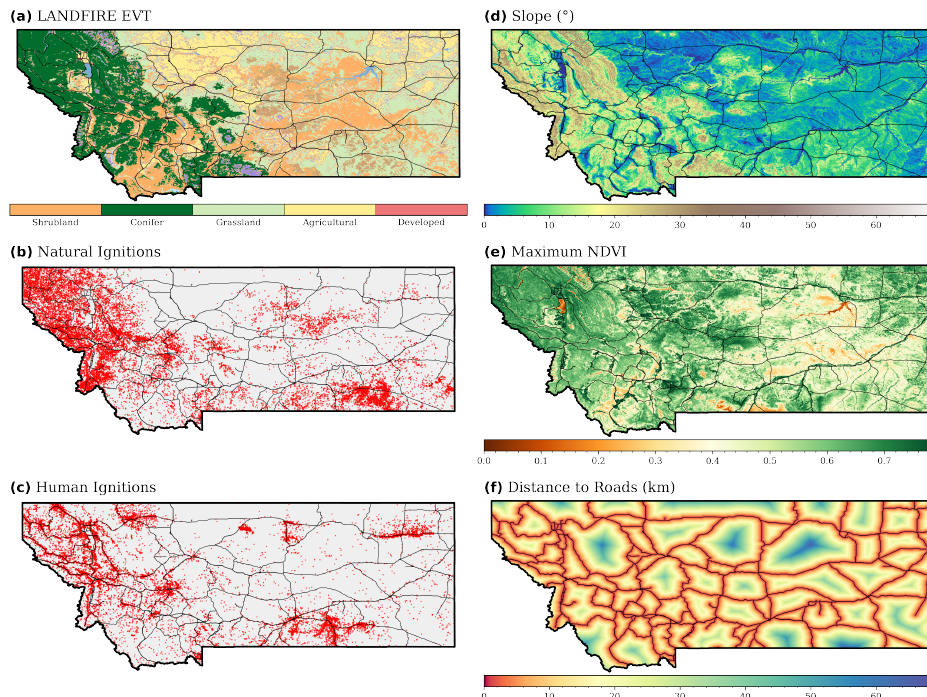
Figure 2. Maps of Montana, USA, shown with primary and secondary roads. ( a ) LANDFIRE Existing Vegetation Type (EVT) ( b ) and ( c ) natural and human-caused ignition locations recorded in the Fire Program Analysis Fire-Occurrence Database (FPA FOD) from 1992–2017. ( d ) Slope from LANDFIRE. ( e ) Maximum Normalized Difference Vegetation Index (NDVI) from 1992–2011. ( f ) Distance to